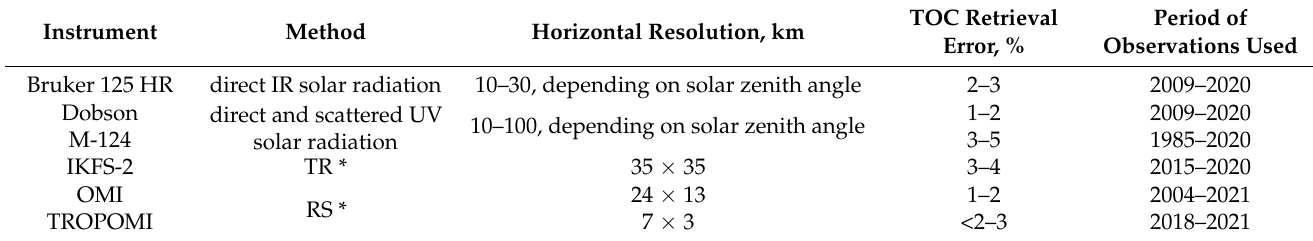
Table 1. Characteristics of the measurement